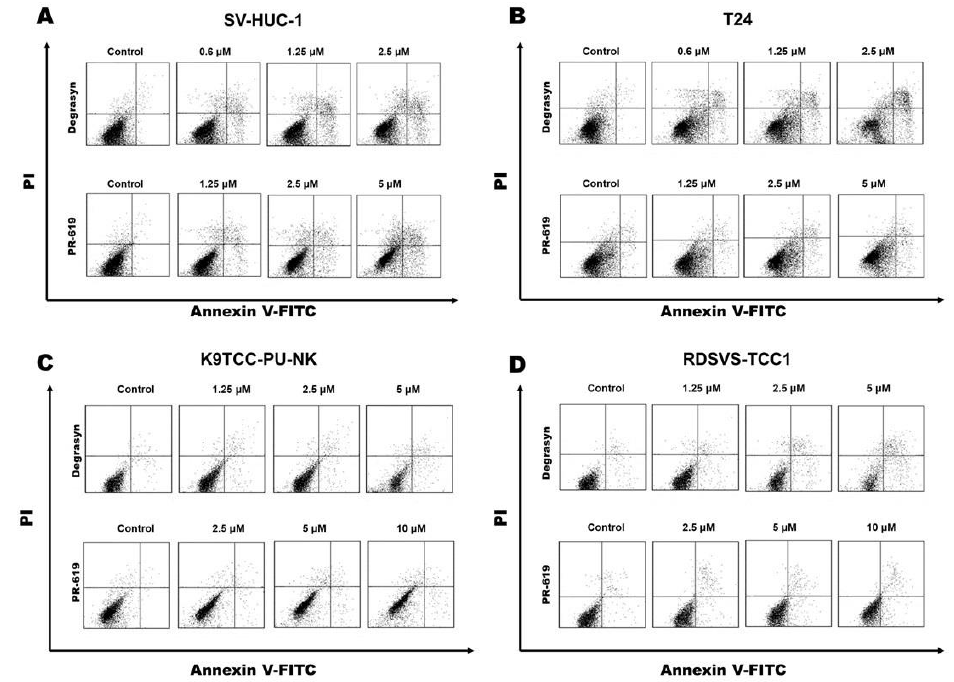
Figure 5. Evaluation of apoptosis induced by Degrasyn and PR-619. Representative dot-plots showing Annexin V-FITC/PI staining of ( A ) SV-HUC-1, ( B ) T24, ( C ) K9TCC-PU-NK, and ( D ) RDSVS-TCC1 cells after 24 h exposure to increasing concentrations of Degrasyn and PR-619.